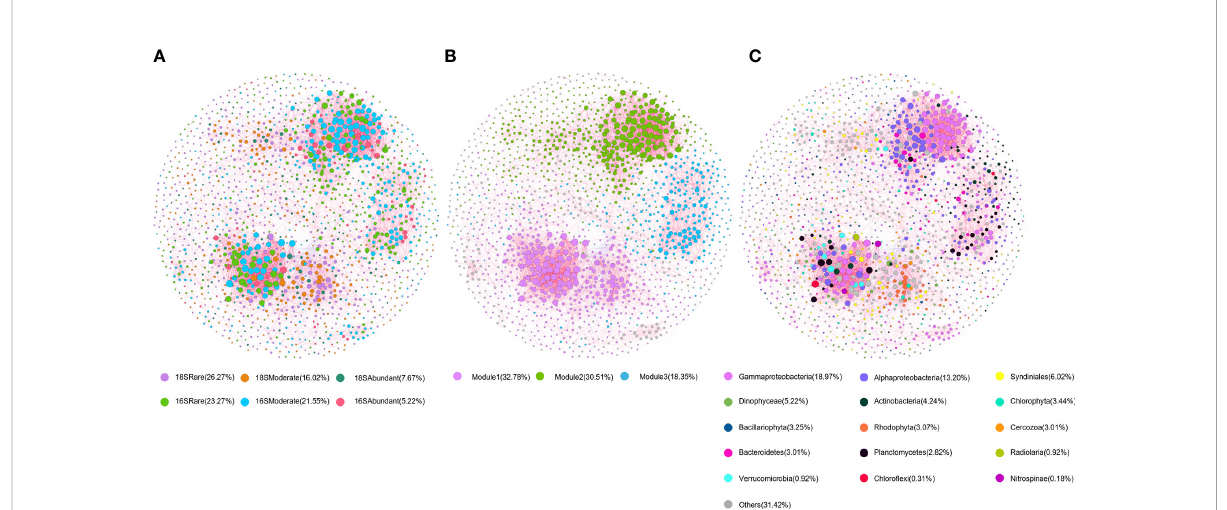
FIGURE 5 Co-occurrence network of planktonic microbiome in SYBH. The network was established by calculating correlations among OTUs. The nodes in the network are colored according to (A) subcommunities of different abundance; (B) modules and (C) taxa. The red and blue lines represent positive and negative correlations, respectively. The sizes of the nodes are scaled to the degree of